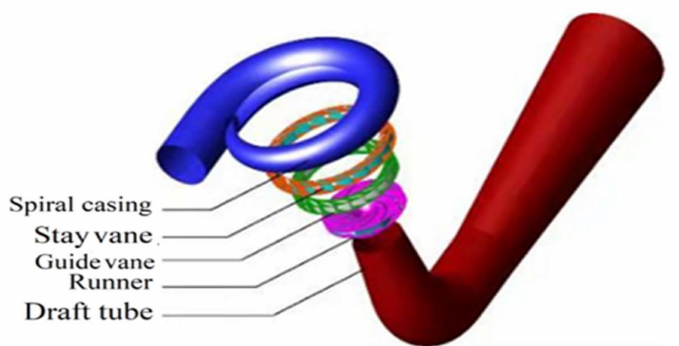
Figure 3. Model pump turbine calculation